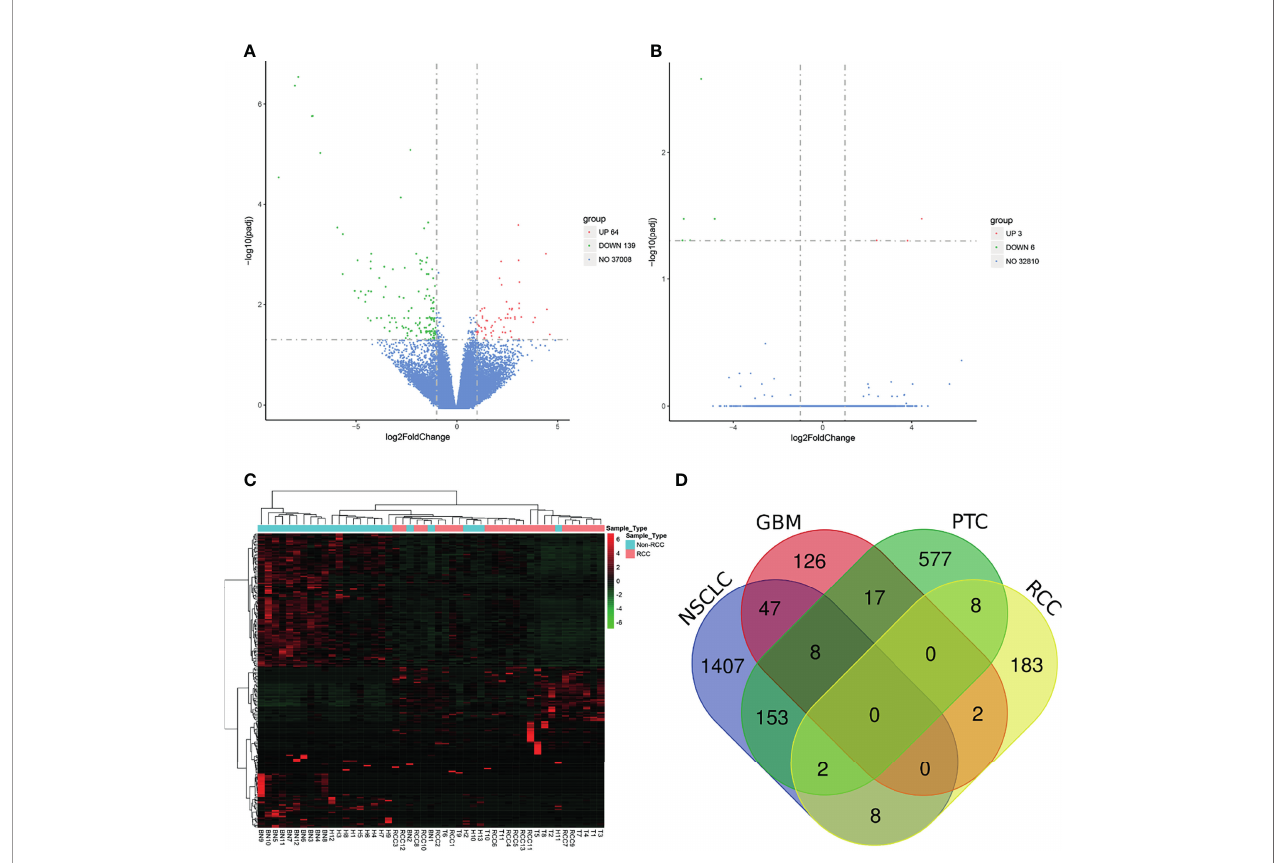
FIGURE 2 | Analysis of differentially expressed genes (DEGs) in the platelet between the renal cell carcinoma (RCC) and control groups. (A) Volcano plot of DEGs between the RCC group and the control group. (B) Volcano plot of DEGs between groups A and B in the control group. (C) Unsupervised cluster analysis of DEGs in those platelet samples. (D) Venn diagram of DEGs in four different tumor